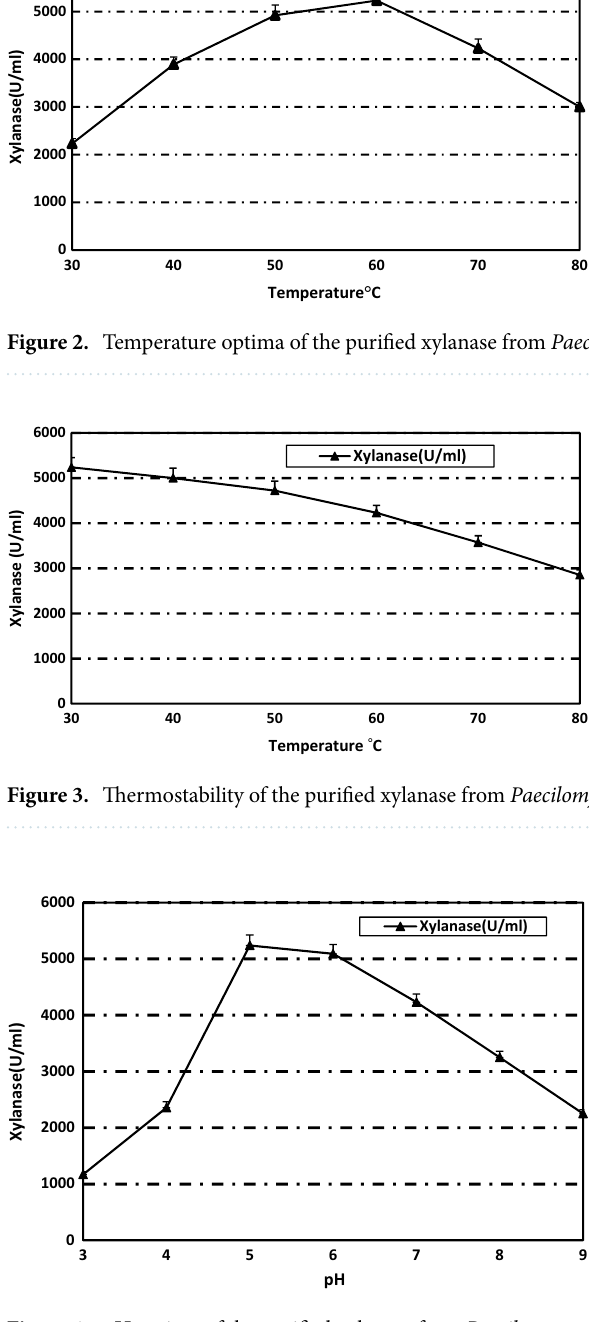
Figure 4. pH optima of the purified xylanase from Paecilomyces